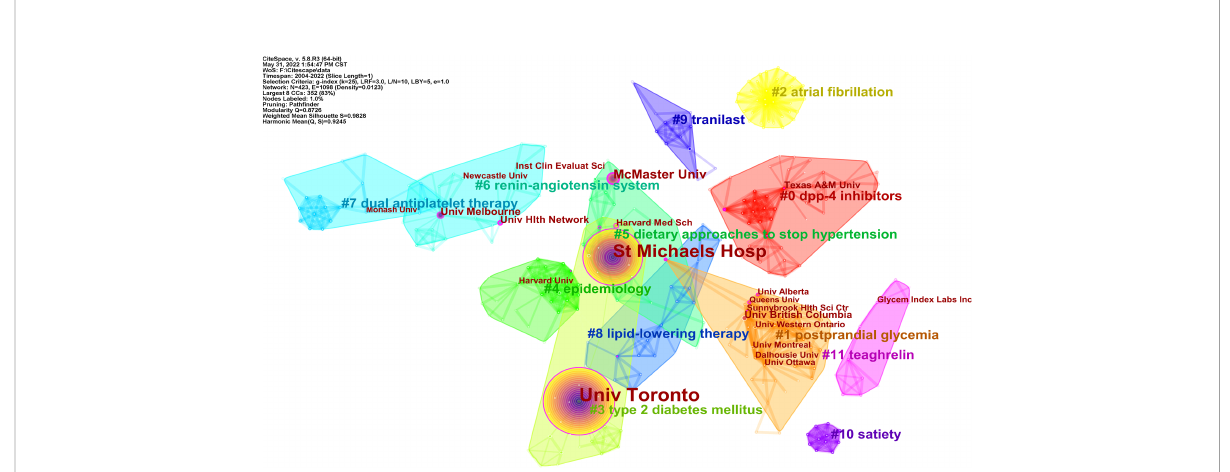
FIGURE 6 Visualization map of institution collaboration analysis related to RNA methylation in DM and its complications. Each node with colorful annual rings represents an institution. Institutions with partnerships make up the different color groups. The text with # represents the keyword clusters of the